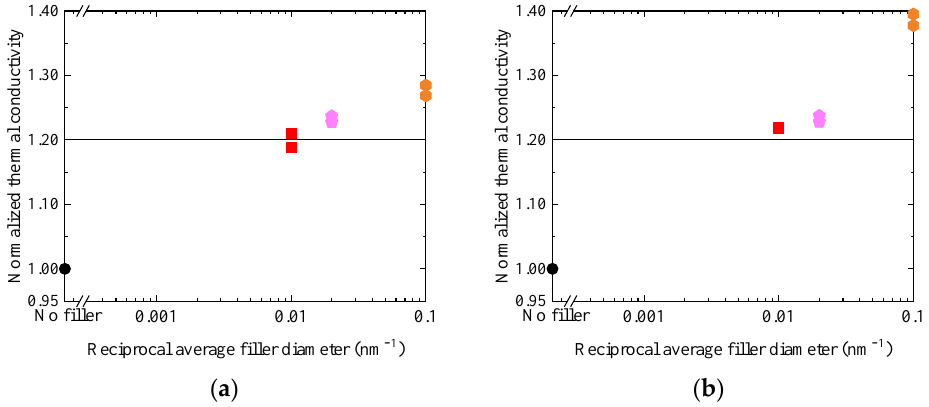
Figure 3. Thermal conductivity as a function of reciprocal filler diameter, measured in epoxy NC samples containing 10-vol% silica. For the sample symbols, refer to Table 1. Several data overlap each other. ( a ) 25 °C, ( b ) 100 °C.